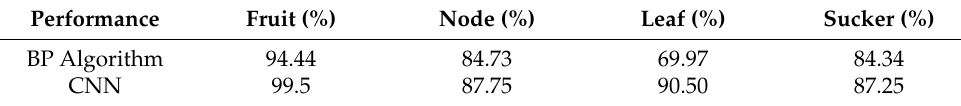
Table 9. Classification performance comparison between the BP algorithm and